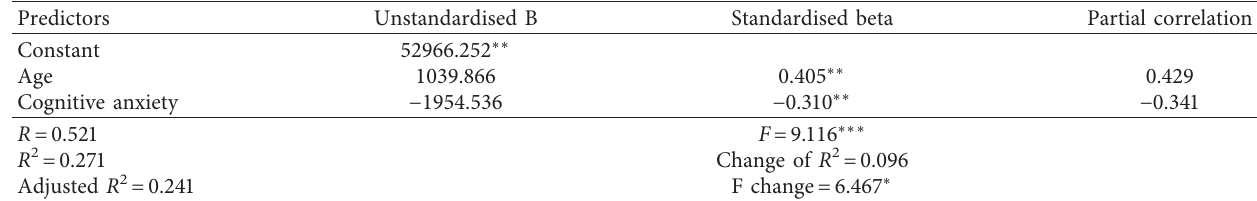
Table 4: Stepwise multiple regression analysis of depression, cognitive anxiety towards pain, the scales of the PRI, and age over total performance times.